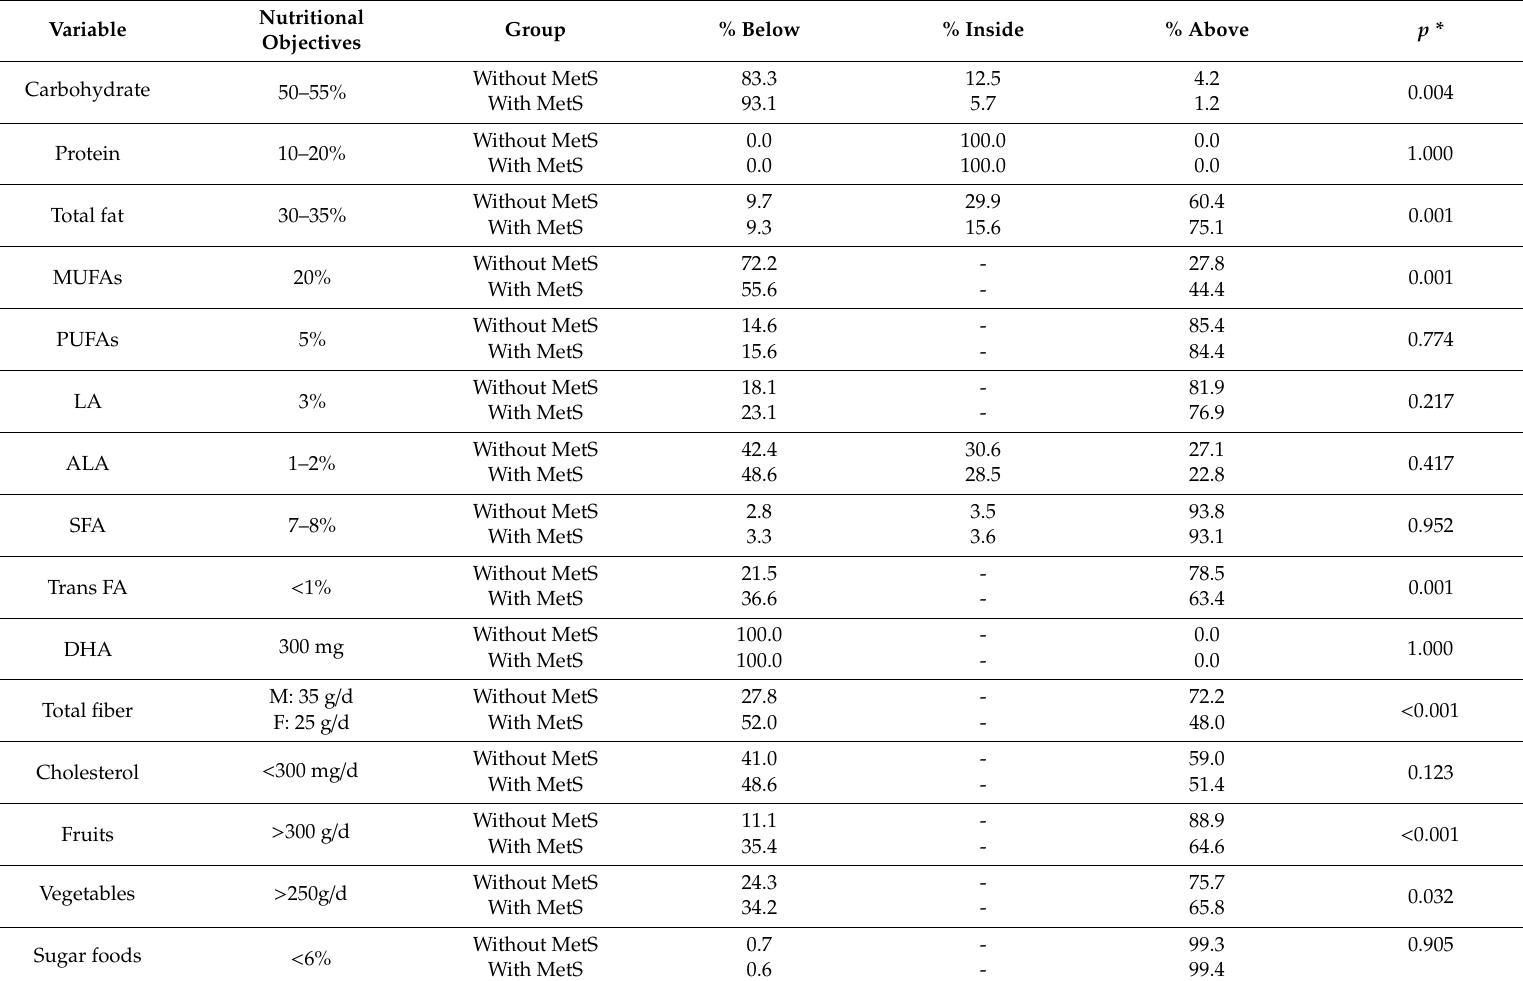
Table 5. Percentage of participants “with Metabolic Syndrome” and “without Metabolic Syndrome” below, inside, and above the 2020 Nutritional Objectives for the Spanish Population proposed by the Spanish Society of Community